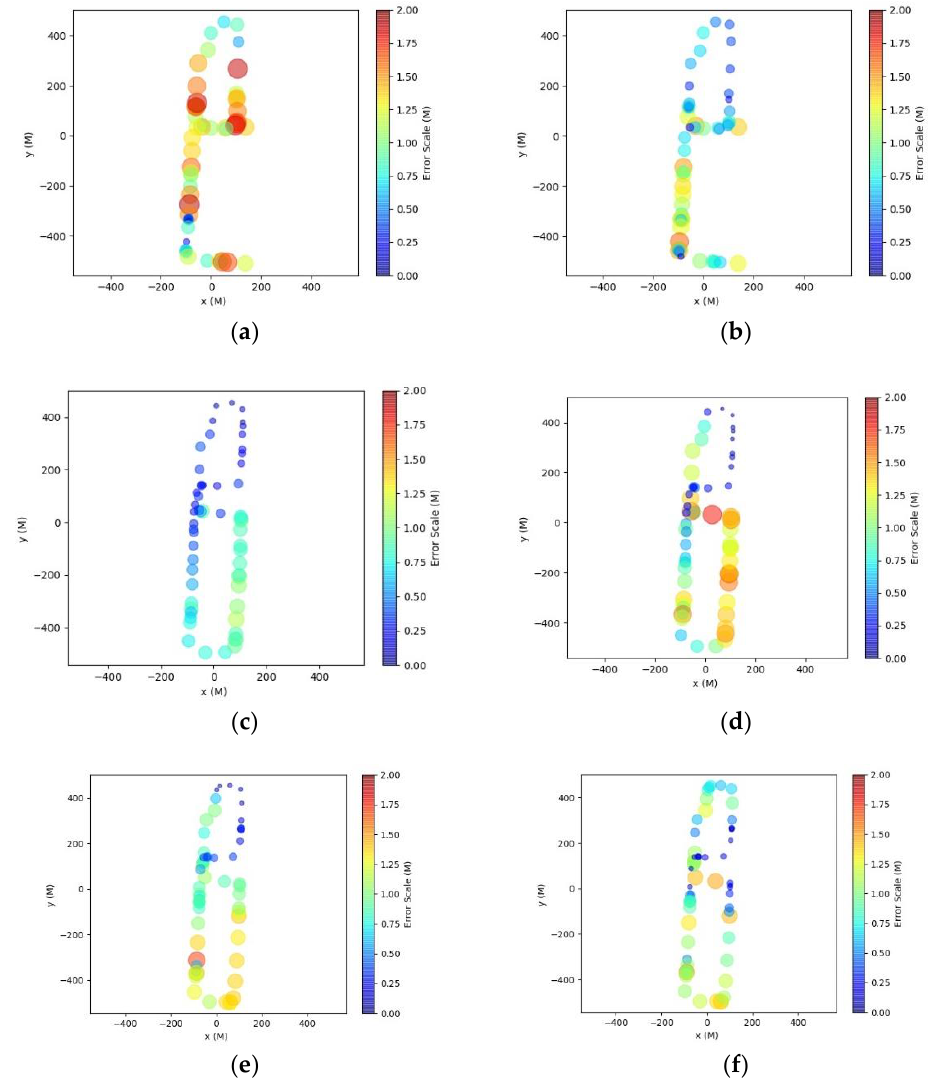
Figure 7. Color maps of accuracy assessment for 10 s slice length (marker size and color indicate error magnitude): ( a ) InvenSense; ( b ) Epson_1; ( c ) Honeywell_1; ( d ) Epson_2; ( e ) Honeywell_2; ( f ) Epson_3. Note that the coordinates have been reduced to a local system for display clarity.